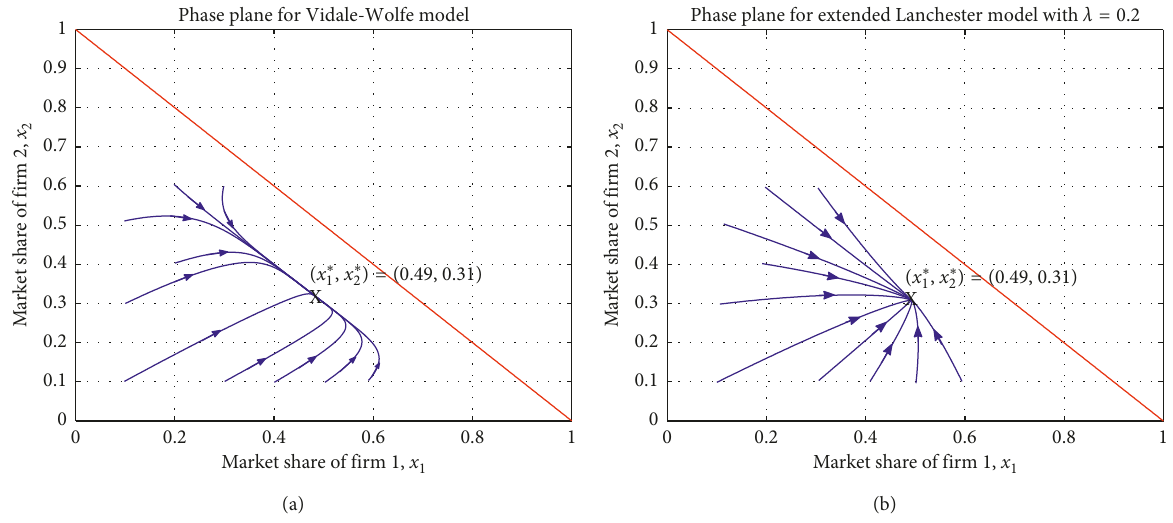
Figure 5: Phase plane of the market shares of firms x � 0 . 35 for firm 1 and k 0 . 3and c 1 Lanchester model expressed in equation (25). It is observed that the models have the same equilibrium point but different dynamics.